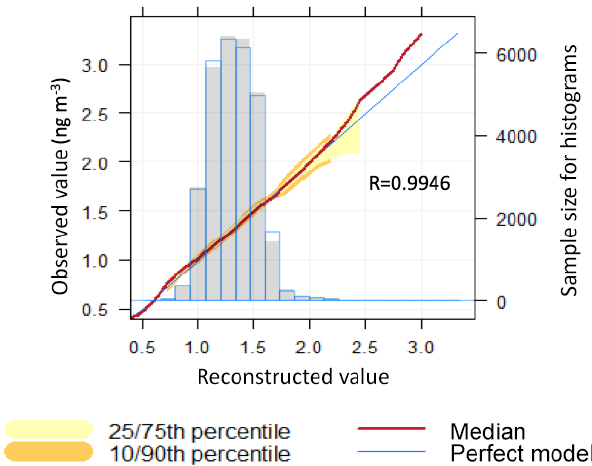
Figure 5. Correlation among total elemental mercury measured and mercury reconstructed by the PMF solution and conditional quan- tile plot showing the difference between PMF solution and observa- tion. The observations are split up into bins according to the corre- spondent reconstructed value. The median prediction line together with the 25th/75th and 10th/90th quantile values are plotted together with a line showing a “perfect model”. Also shown is a histogram of reconstructed values (shaded grey) and a histogram of observed values (shown as a blue